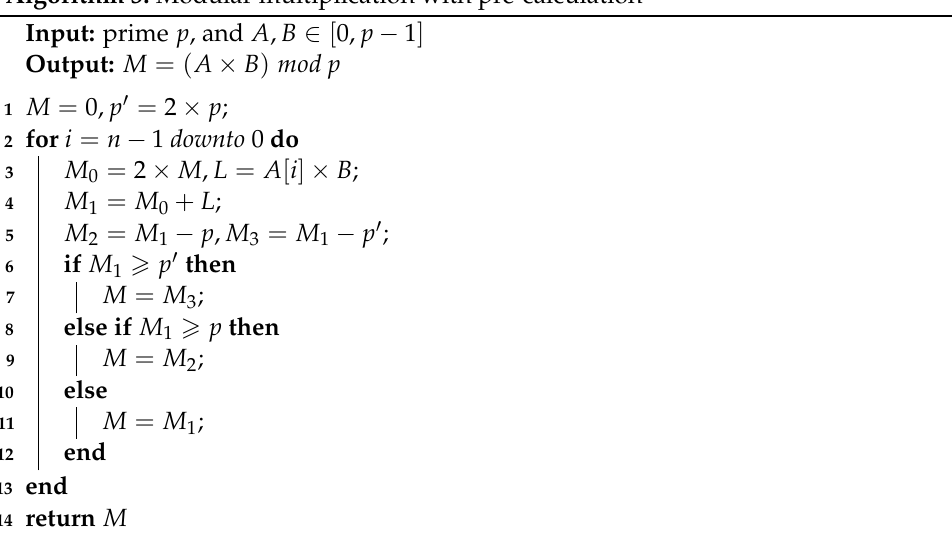
Algorithm 3: Modular multiplication with